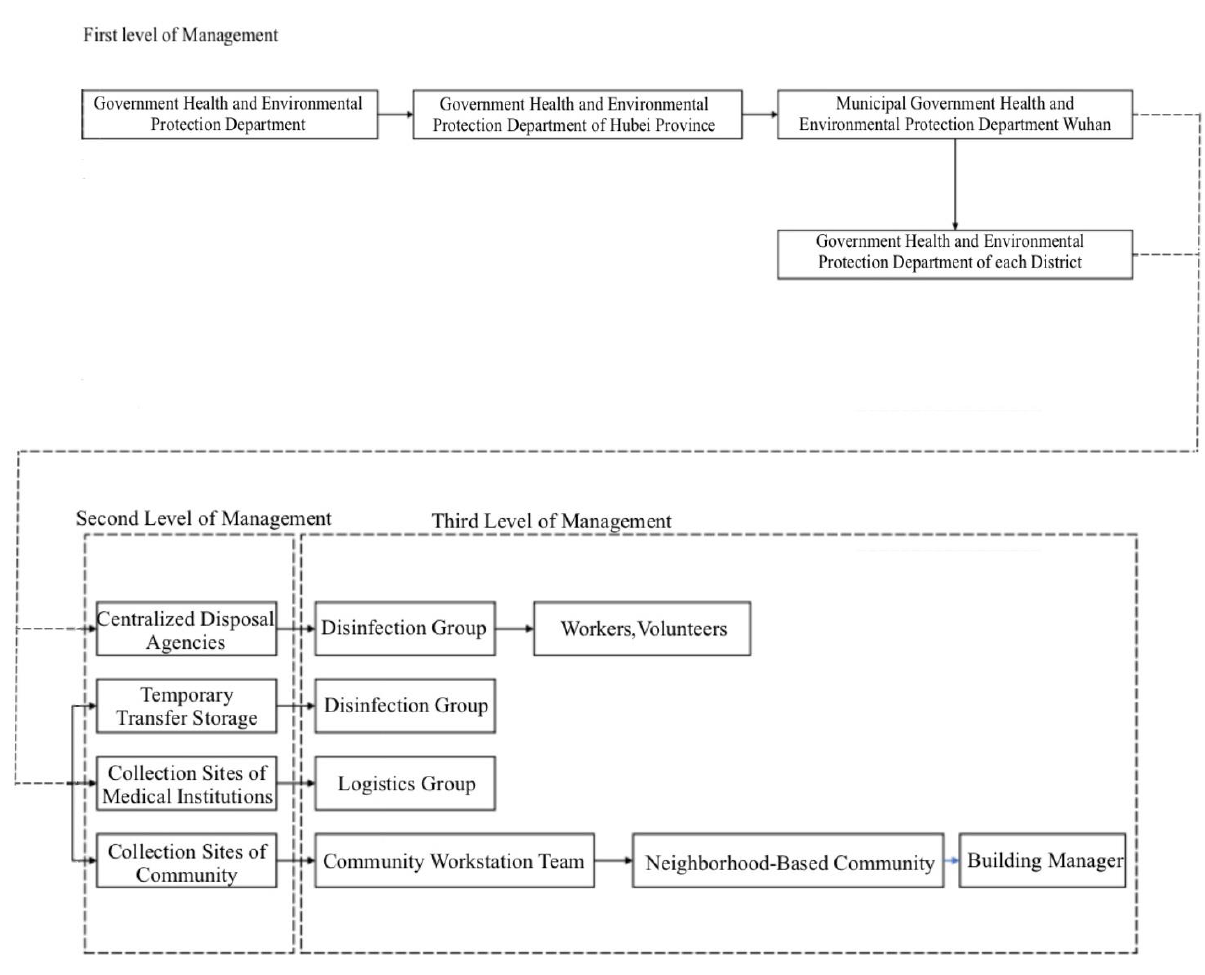
Figure 6. Medical waste hierarchy management